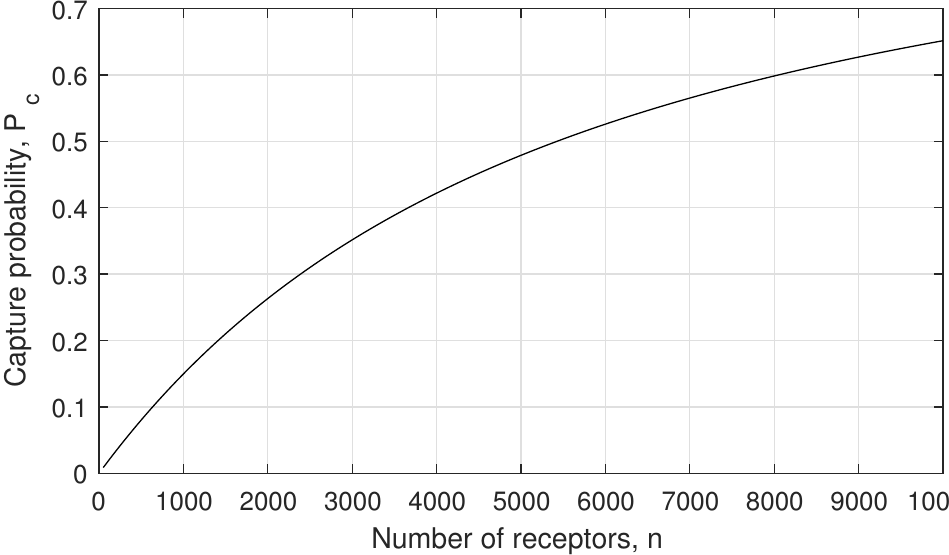
Figure 4. Capture probability P c as a function of the number of receptors, n